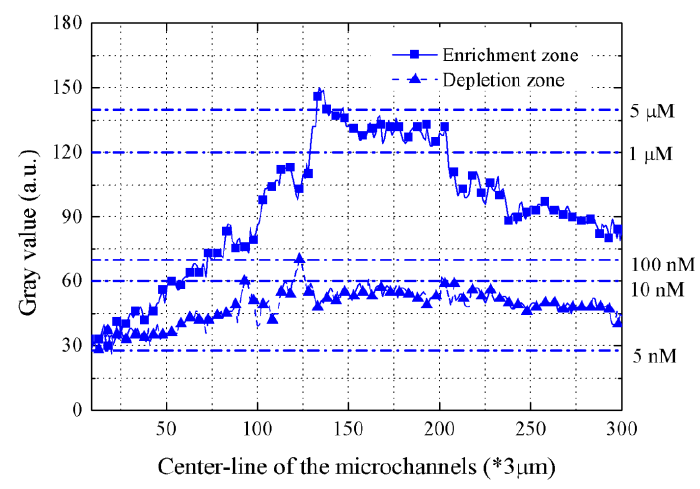
Figure 4. Plot of FITC fluorescence intensity with initial concentration of 10 nM in the center-line of the microchannels.